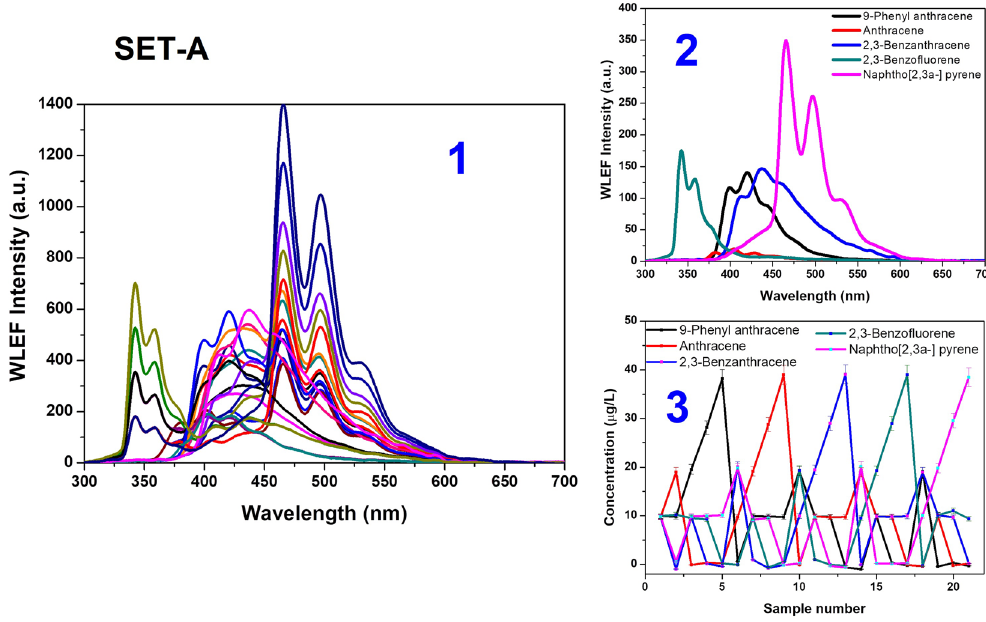
Figure 4. Spectral deciphering and quantification of complex mixtures of analyte (Set A) using MCR- ALS multivariate analysis. (1) WLEF spectra of analyte, (2) spectral information of analytes and (3) their concentration profiles with 3% error bar [WLEF spectra are averaged for 5